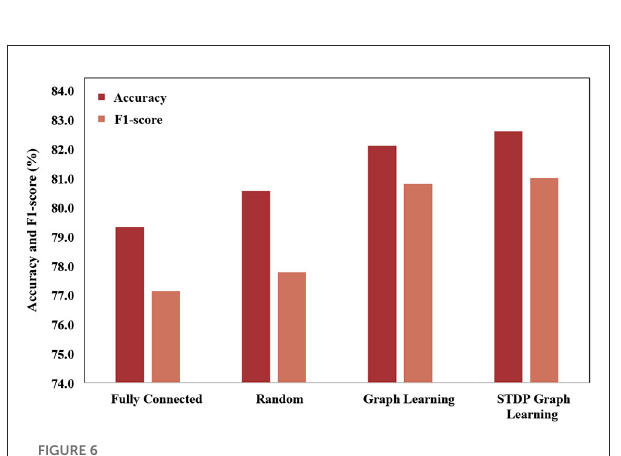
FIGURE7 Performance comparison of different time contexts.